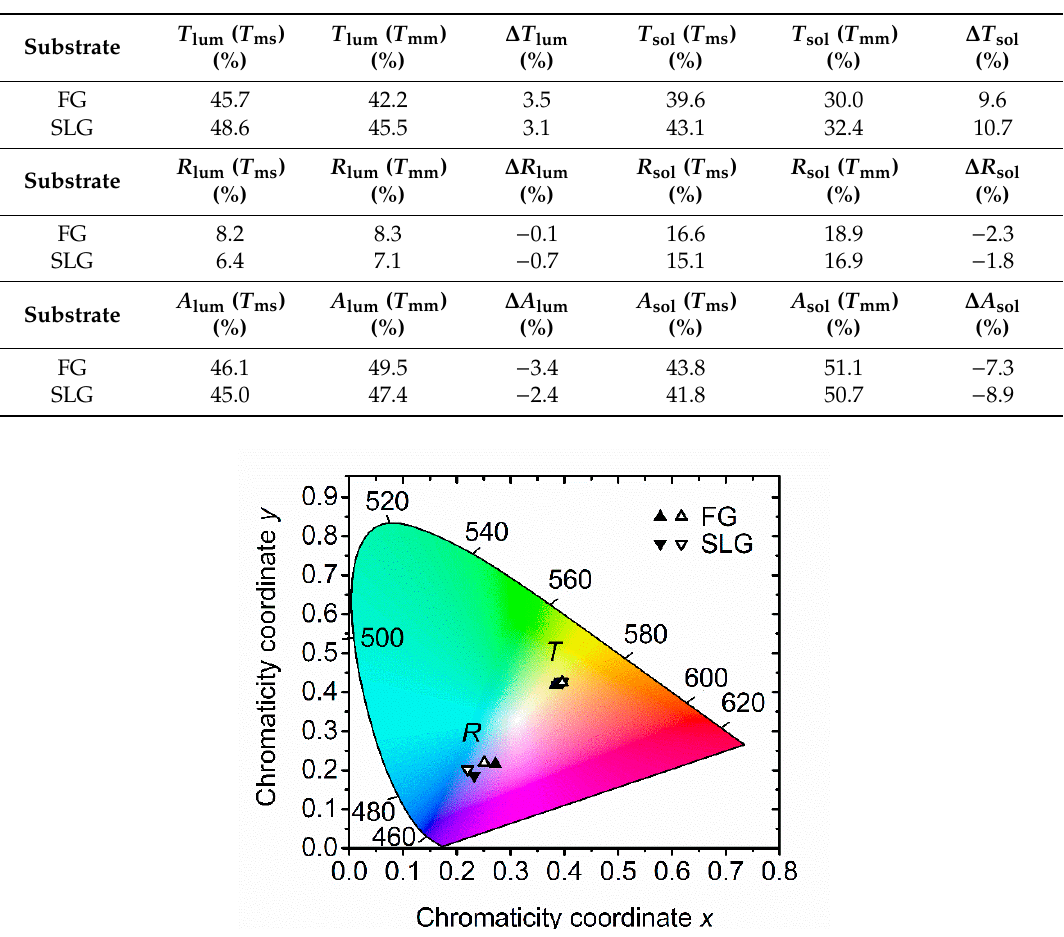
Table 1. Thermochromic properties of the ZrO 2 / V 0.984 W 0.016 O 2 / ZrO 2 coatings deposited on 0.1 mm thick flexible glass (FG) and 1 mm thick soda-lime glass (SLG) substrates are presented. For the coatings